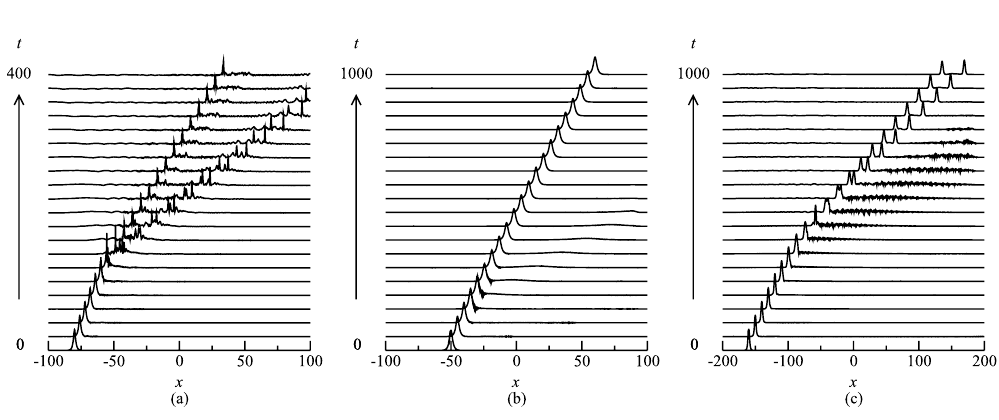
Figure 6. Examples of the evolution of the unstable solitons. ( a ) Ω = 9.86, κ = 10, m = 0, c = 0, and δ = 0.2; ( b ) Ω = − 9.89, κ = 10, m = 0, c = 0.2, and δ = 0.1; and ( c ) Ω = 9.69, κ = 10, m = 0.3, c = 0.2, and δ =